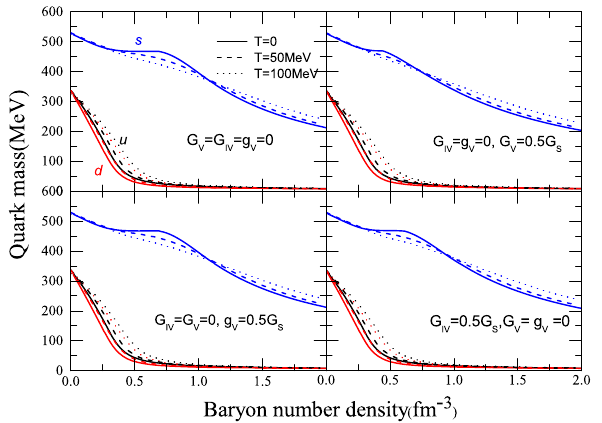
Fig. 2 Constituent mass for u , d , and s quarks as functions of baryon density in SQM within different vector interaction at finite temperature